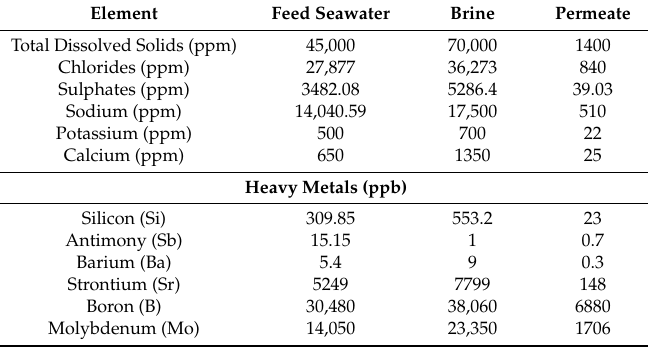
Table 3. The characterization results of the seawater, brine and permeate from the TFC PA/0.2 wt. % AG membrane.